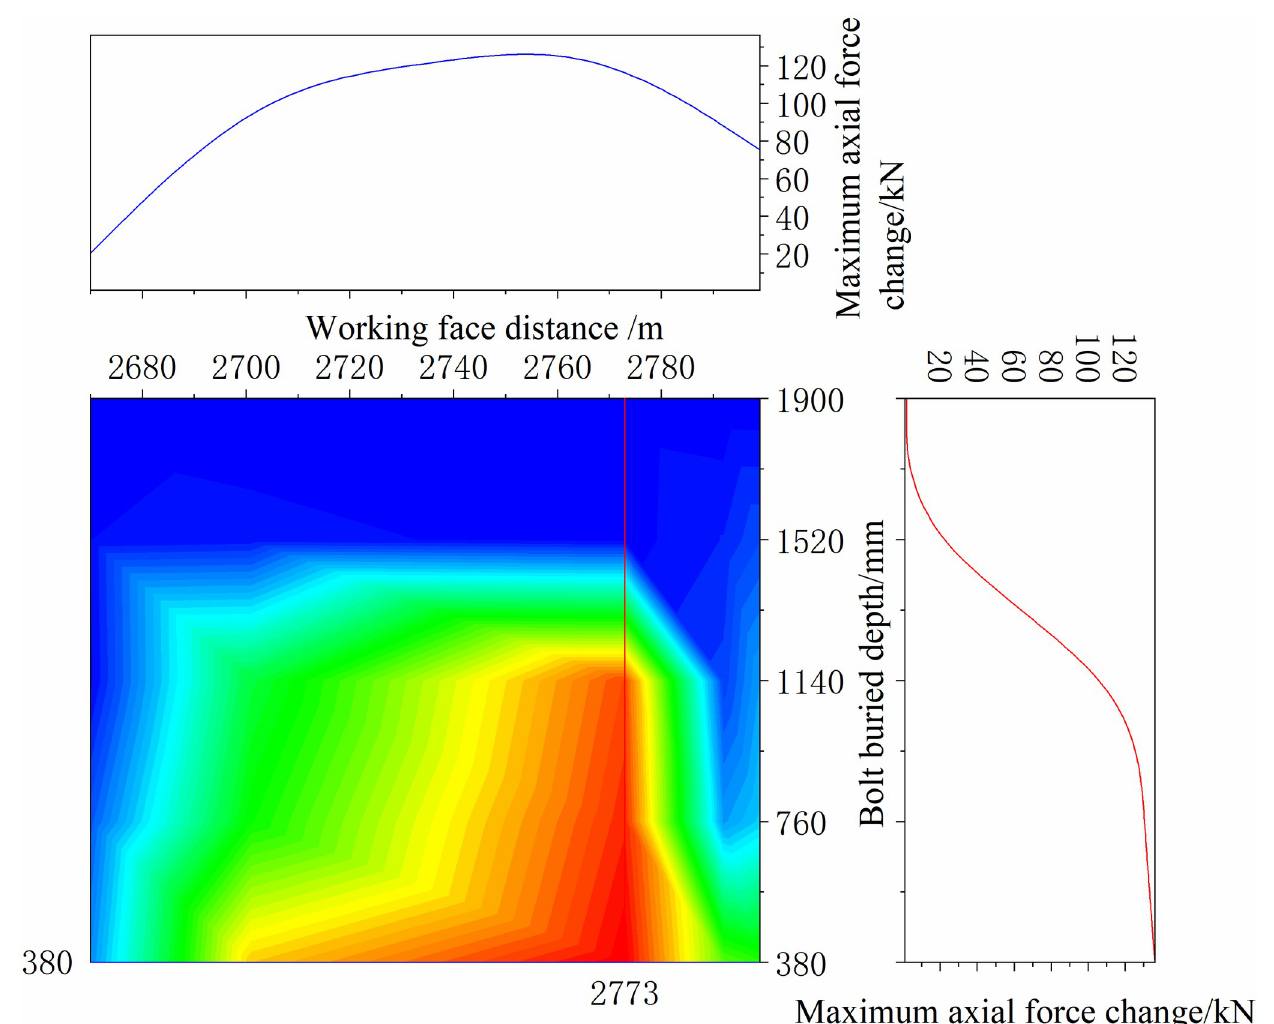
Fig 36. Continuously distributed contour profile curves of bolt monitoring data of positive bolt.